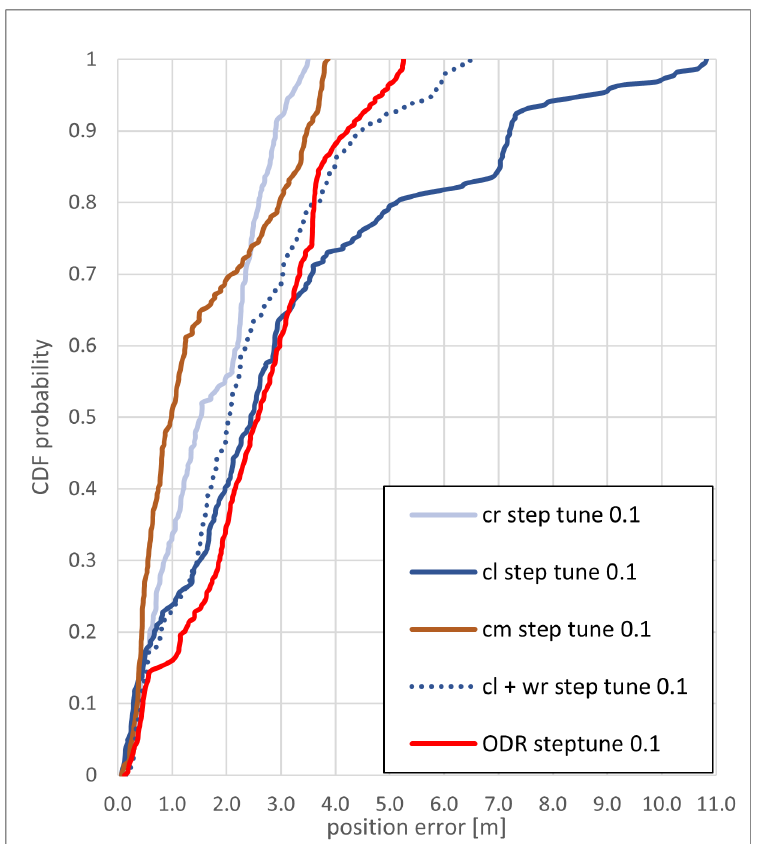
Figure 9. The cm and cr method reached an overall similar accuracy, with the cm method reaching an accuracy of less than 4 m and the cr method reaching a accuracy of just less than 3 m in 90% of the steps.